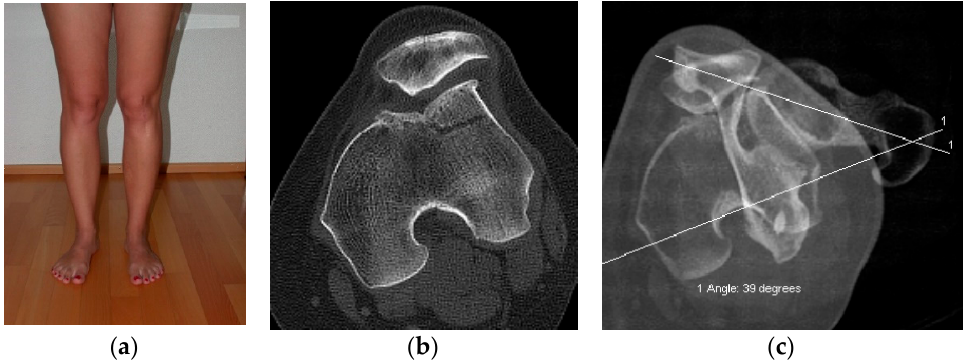
Figure 3. ( a ) View from the front visualizing increased femoral antetorsion on the left side after Figure 3. Postoperative standing examination ( a ) View from the front visualizing increased femoral deepening trochleoplasty and persisting lateral patellar subluxation; ( b ) axial computed tomogra- antetorsion on the left side after deepening trochleoplasty and persisting lateral patellar subluxation; phy showing the situation after deepening trochleoplasty with persisting lateral patella subluxa- ( b ) axial computed tomography showing the situation after deepening trochleoplasty with persisting tion (the same patient as in Figure 3a); ( c ) Rotational study with computed tomography showing lateral patella subluxation (the same patient as in Figure 3a); ( c ) Rotational study with computed increased femoral antetorsion of 39° (the same patient as in Figure 3a,b). tomography showing increased femoral antetorsion of 39 ◦ (the same patient as in Figure